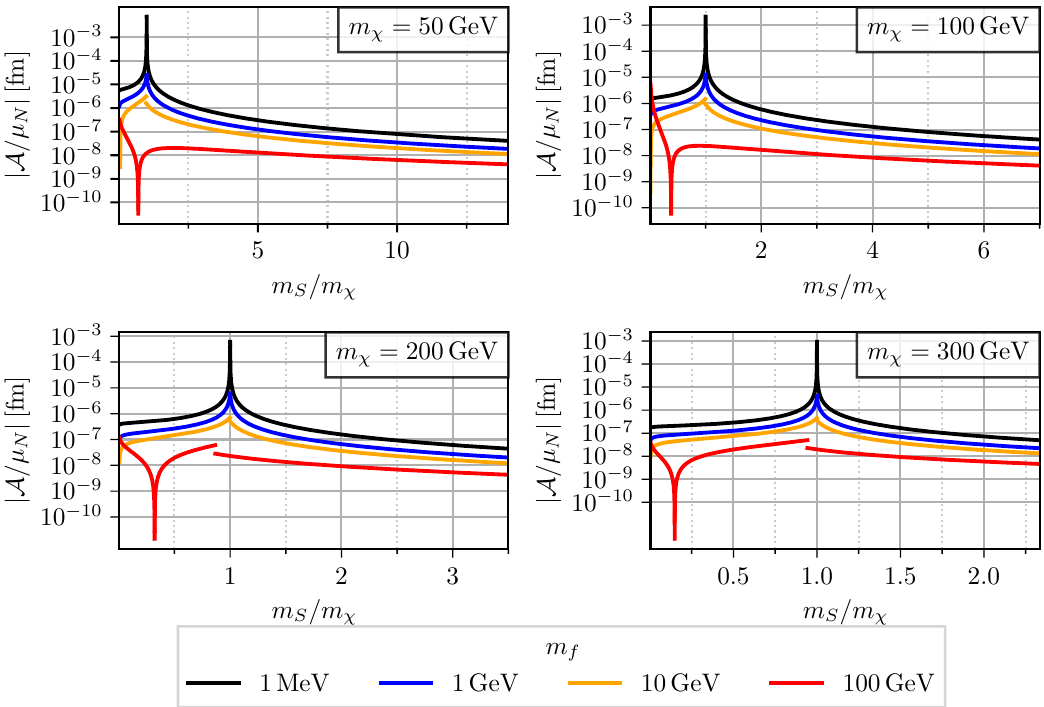
Figure 4. Same as figure 3 but for a Majorana fermion that interacts with a charged scalar S and a charged fermion f . For the plot, we assumed for concreteness c L = 1 , c R = 0 and Q f = − 1